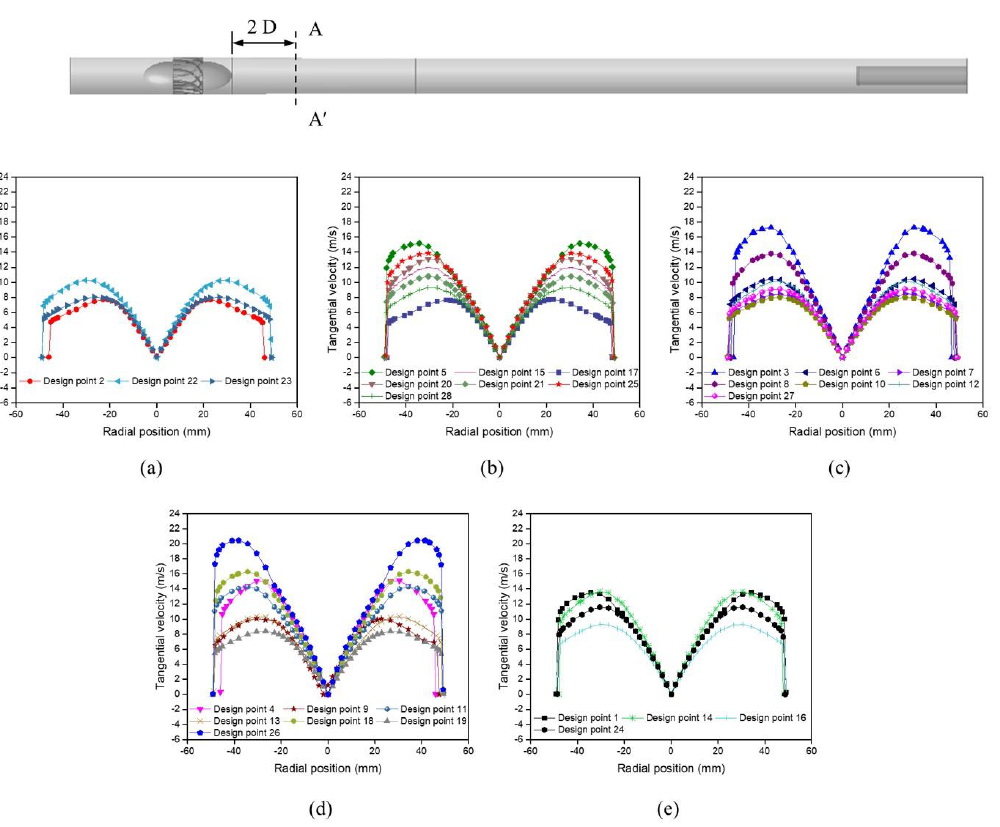
Figure 6. Tangential velocity at 2D downstream of the ISE: ( a ) at 5 vanes, ( b ) at 6 vanes, ( c ) at 7 vanes, ( d ) at 8 vanes, and ( e ) at 9 vanes.